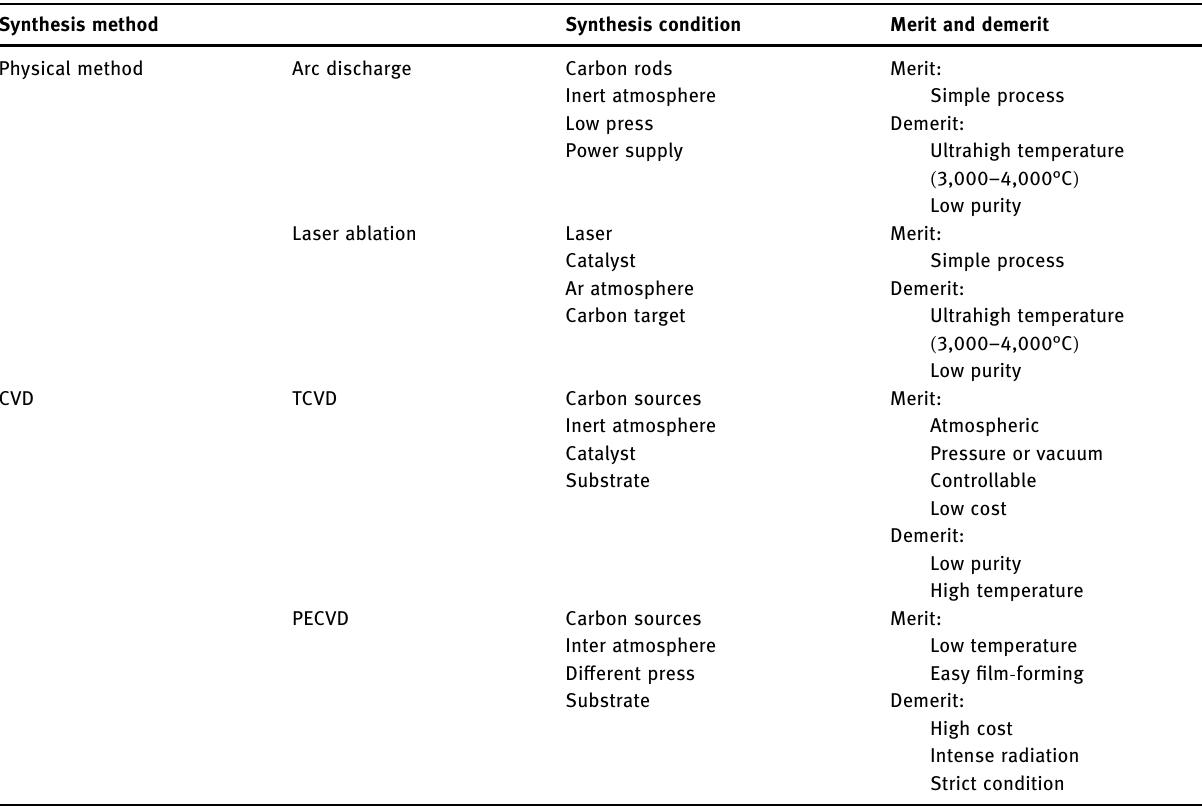
Table 1: A comparison of the CNT synthesis method Synthesis